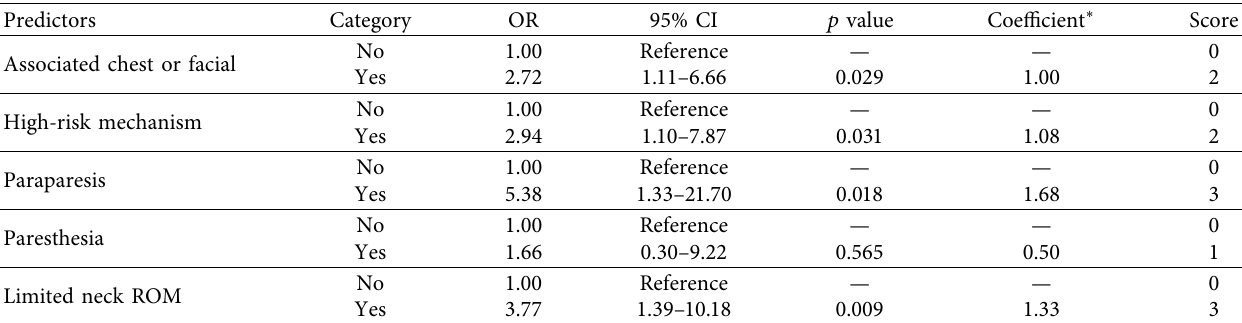
Table 2: Significant predictors of cervical spine fracture and assigned item